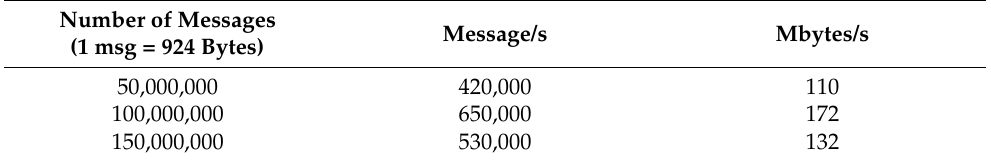
Table 4. The average throughput of Apache Kafka for different numbers of messages sent by the